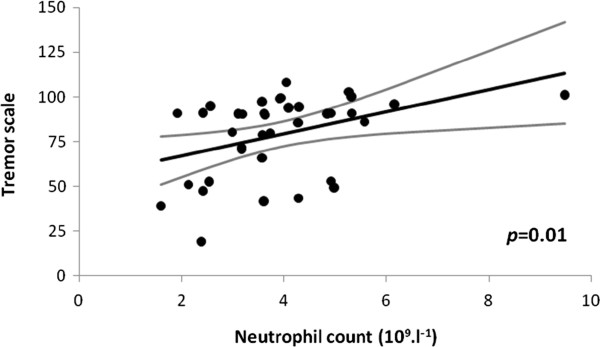
Relationship of mean tremor whilst seated to neutrophil count in core group, after adjustment for time since diagnosis (to 6 years). Regression line and 95% CI are shown. Outlier for neutrophil count (9.48 x109.l-1) not influential (size of effect after exclusion: decrease in tremor of 7.9 (95% CI 1.3, 14.5) units per 109.l-1 cell increment, p=0.02). Tremor scale: 0 = most intrusive, 100 = no tremor (N.B. 3 values >100 (i.e. 101, 103, 108) consequent on adjustment for time since diagnosis).